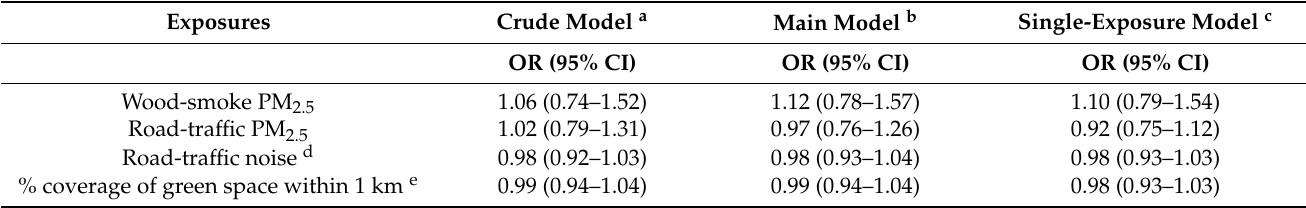
Table 3. Odds ratios for the associations between environmental exposures and use of antihypertensives in the main model.